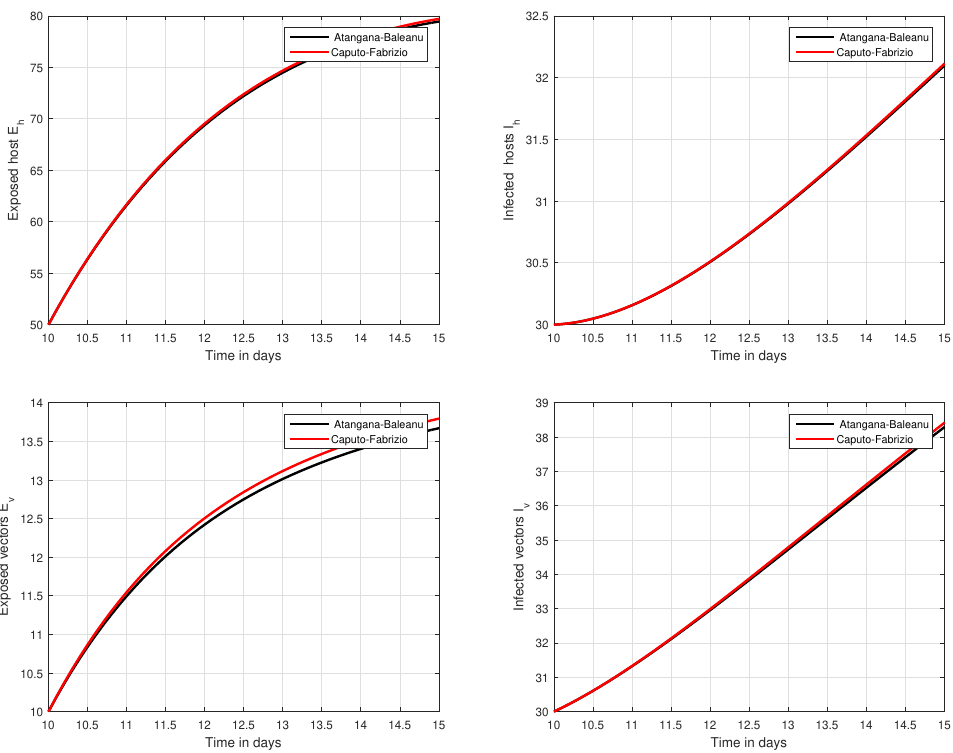
Figure 11. Time series analysis to compare the proposed CF and ABC operator from day 10 to day